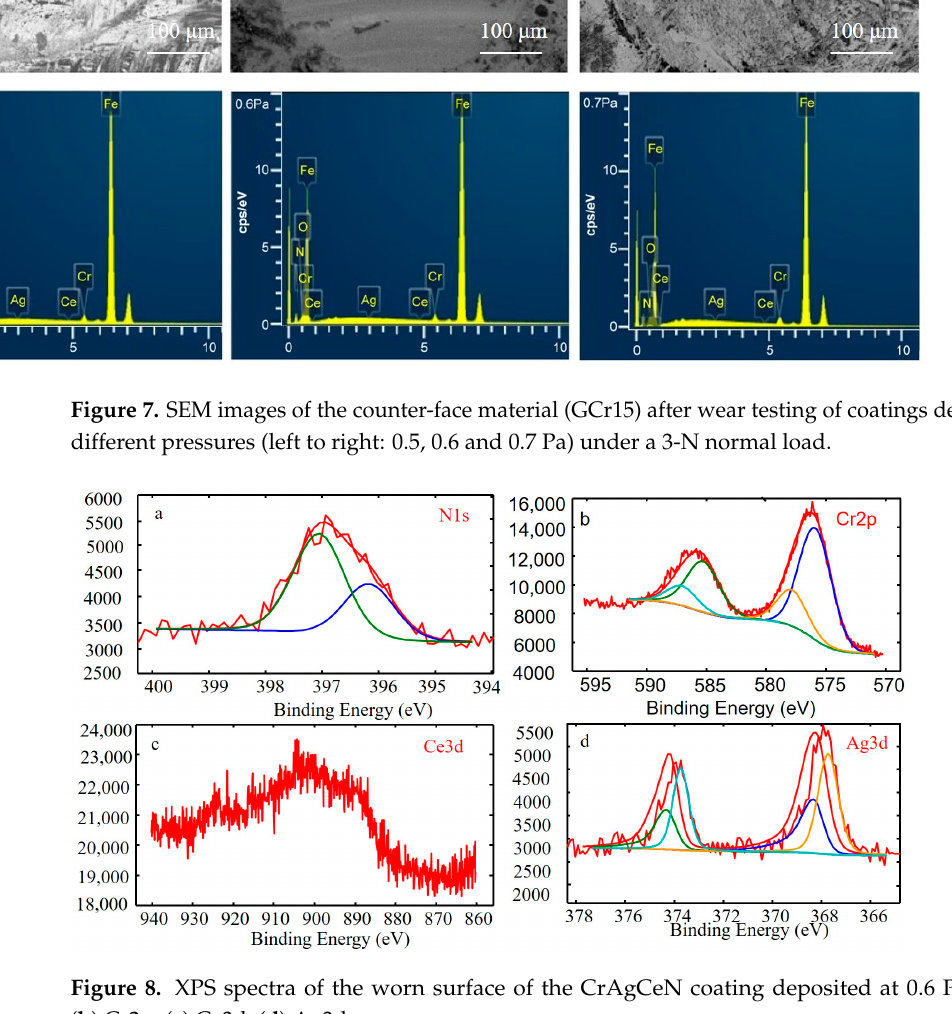
Figure 7. SEM images of the counter-face material (GCr15) after wear testing of coatings deposited at different pressures (left to right: 0.5, 0.6 and 0.7 Pa) under a 3-N normal load.